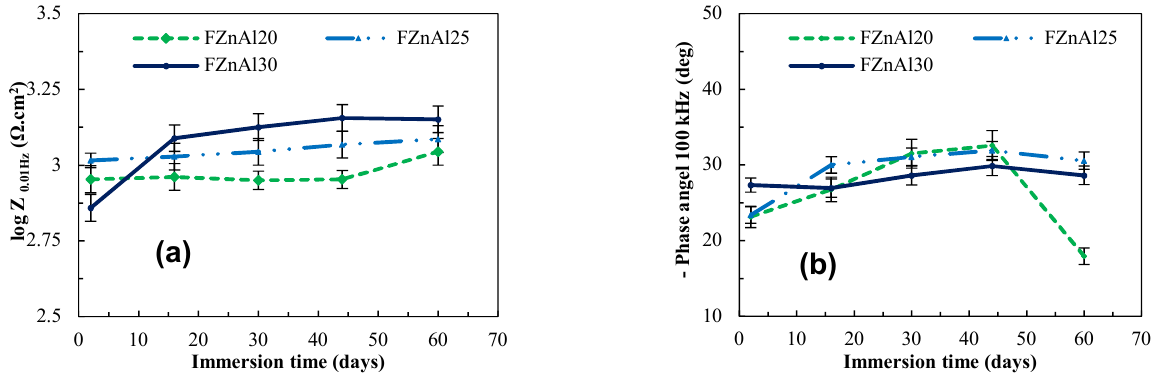
Figure 3. The equivalent electric circuit of silicate coatings with flake ZnAl pigments for various immersion times in NaCl (3.5 wt%): R s , R c , R ct , C c , C dl , and CPE represent solution resistance, coating resistance, charge transfer resistance, coating capacitance, double-layer capacitance, and constant phase element, respectively.